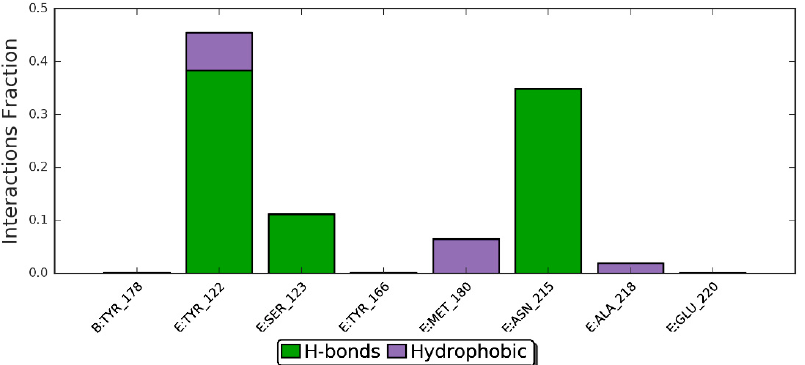
Figure 10. Per-residues analysis of the ZER in complex with integrin α v β 3 protein in the presence of TP5-iRGD peptide; the analysis was based throughout the 20 ns molecular dynamics simulations.